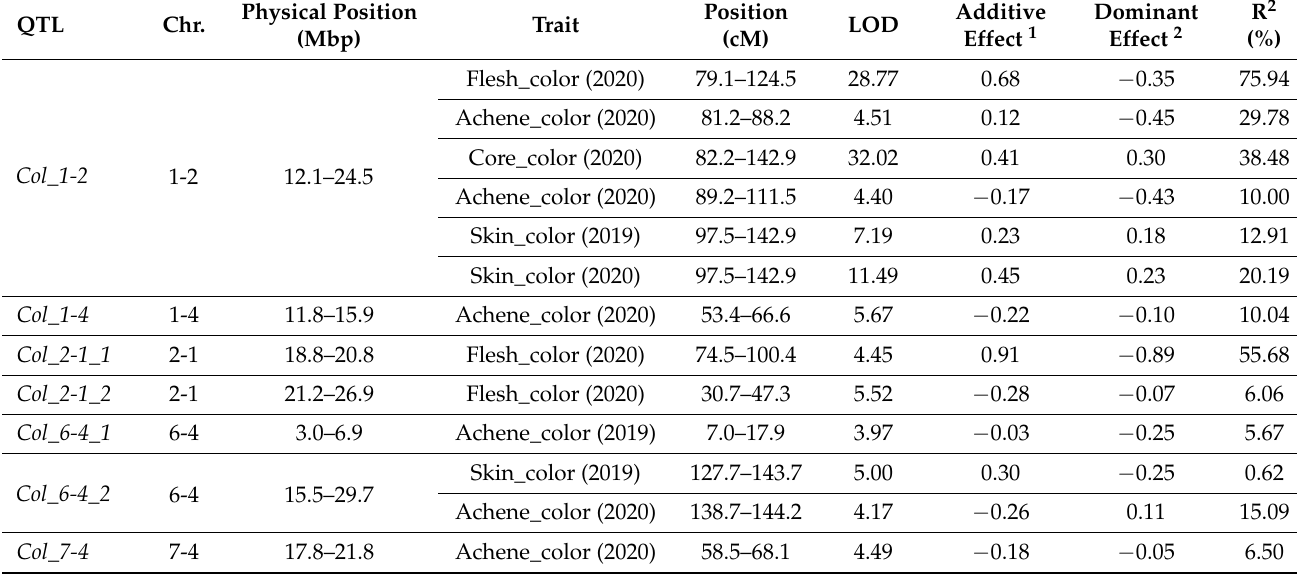
Table 2. QTLs for fruit color detected in the ‘BS F 2 (II)’